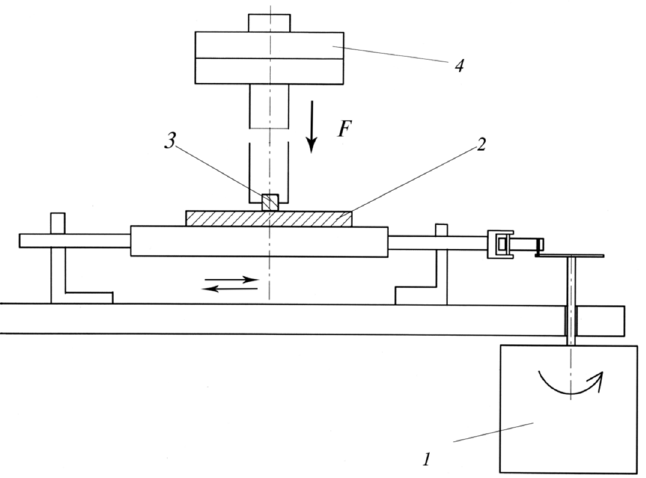
Figure 2. Scheme of wear testing apparatus working in reciprocating mode: 1—reciprocating drive; 2—sample; 3—counterbody; 4—load unit; F is loading force.